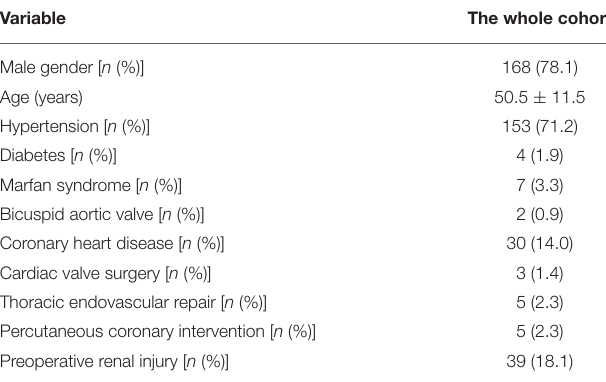
TABLE 1 | Characteristics of 215 consecutive patients with ADIAD who underwent treatment using the Brain-Heart-first strategy.